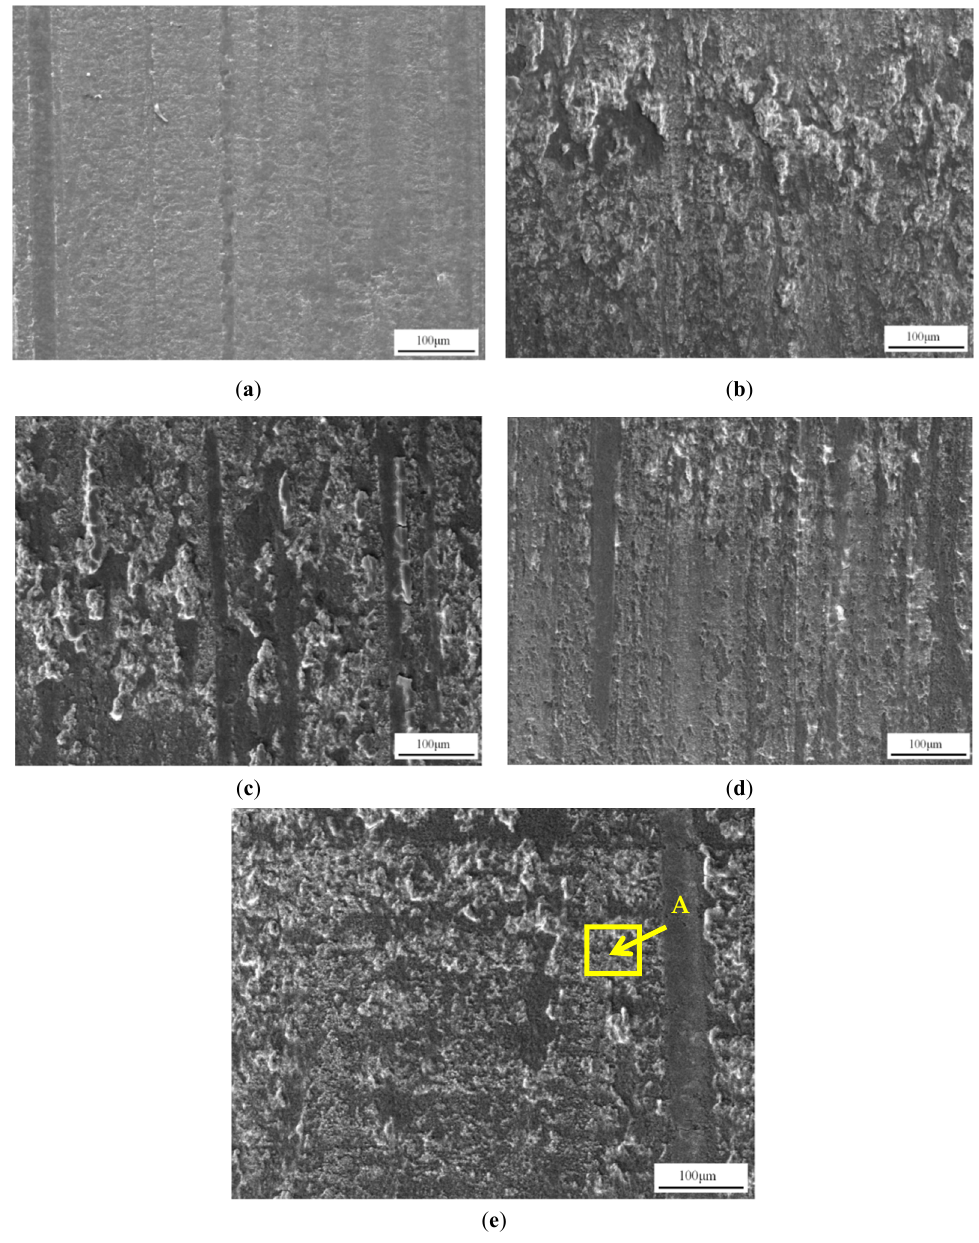
Figure 4. Worn surfaces of Si 3 N 4 -hBN composites pins against UHMWPE disc in SBF: ( a ) SN0 pin; ( b ) SN5 pin; ( c ) SN10 pin; ( d ) SN20 pin; ( e ) SN30 pin.